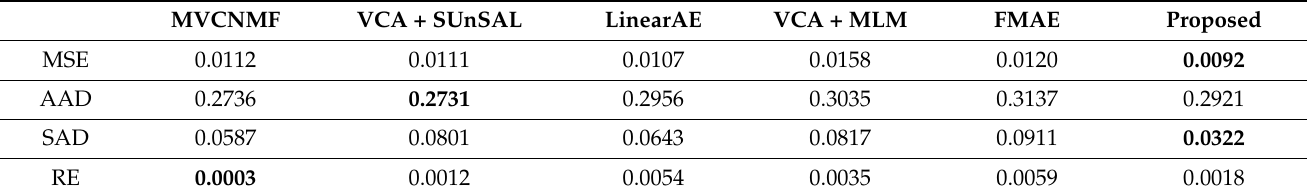
Figure 5. Estimated abundance maps for Nonlinear Mixed Image. From left to right for different endmembers. From top to bottom for different methods. Table 3. Comparison of different methods on Linear Mixed Data. Best results are reported in